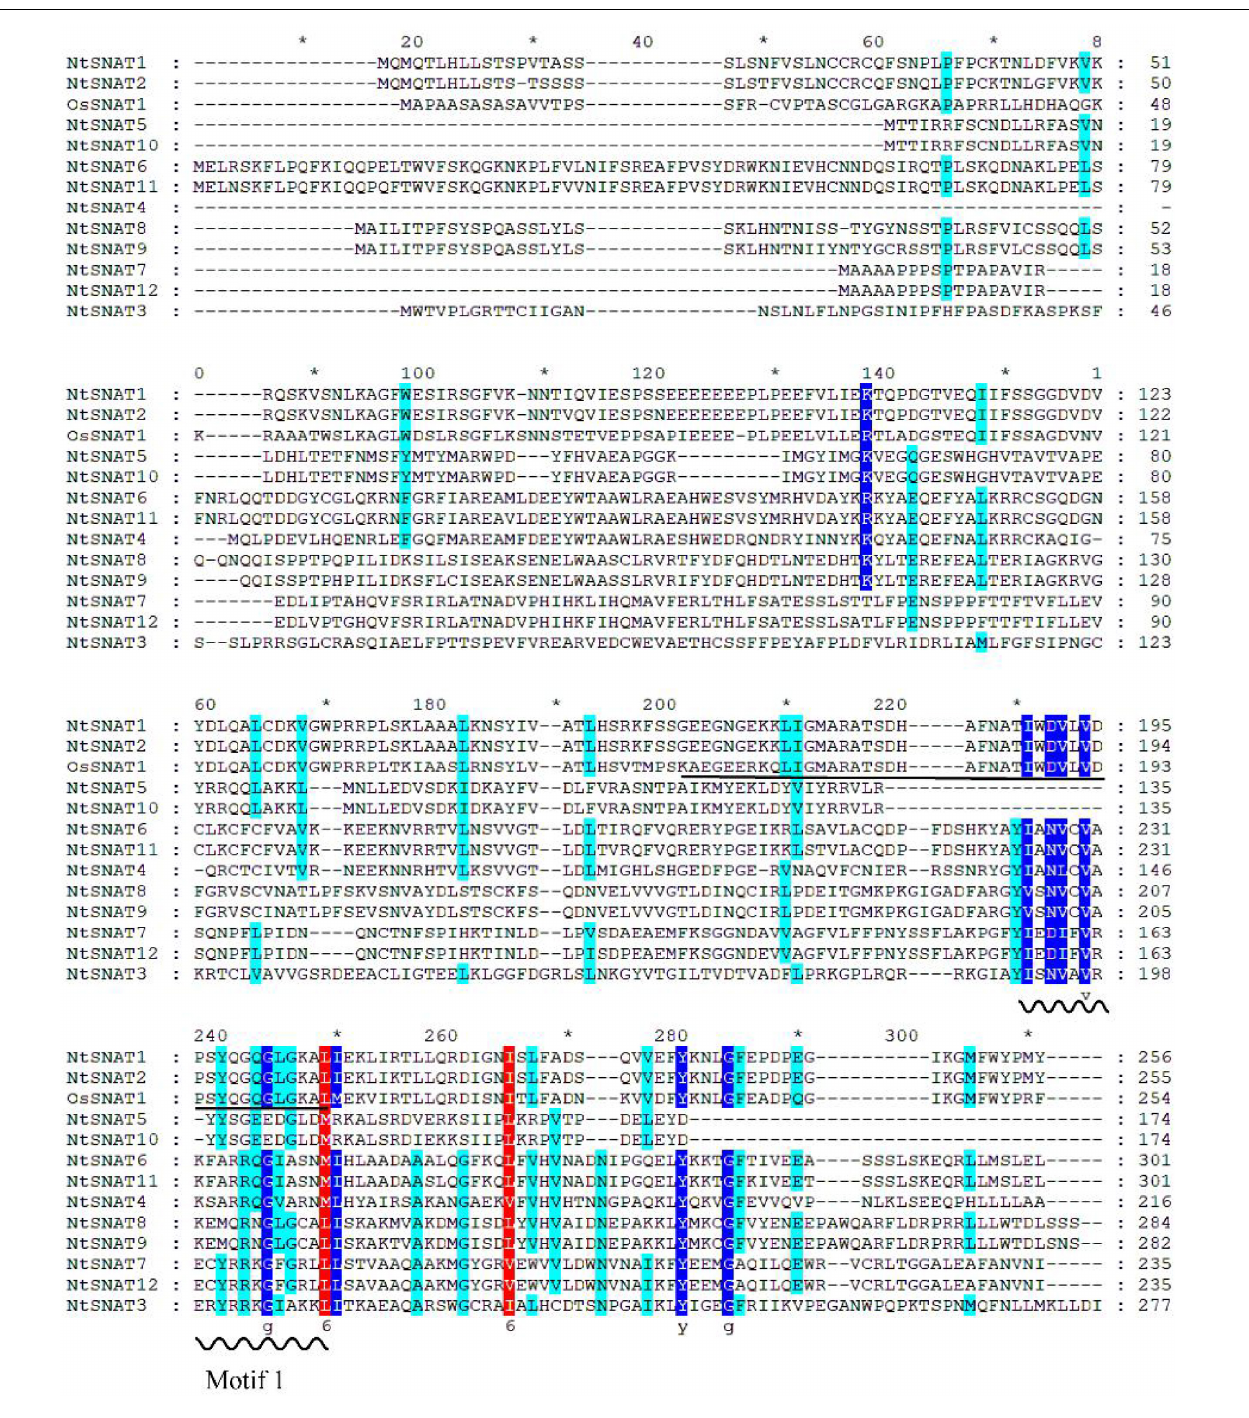
FIGURE 2 | Multiple sequence alignment of OsSNAT1 and NtSNAT proteins. The wavy line in the figure indicates conserved motif 1, and the conserved acetyl-CoA binding motif is underlined. The conserved amino acid residues are indicated by colored shading. The asterisk “*” represent the length of every twenty amino acids (including blanks